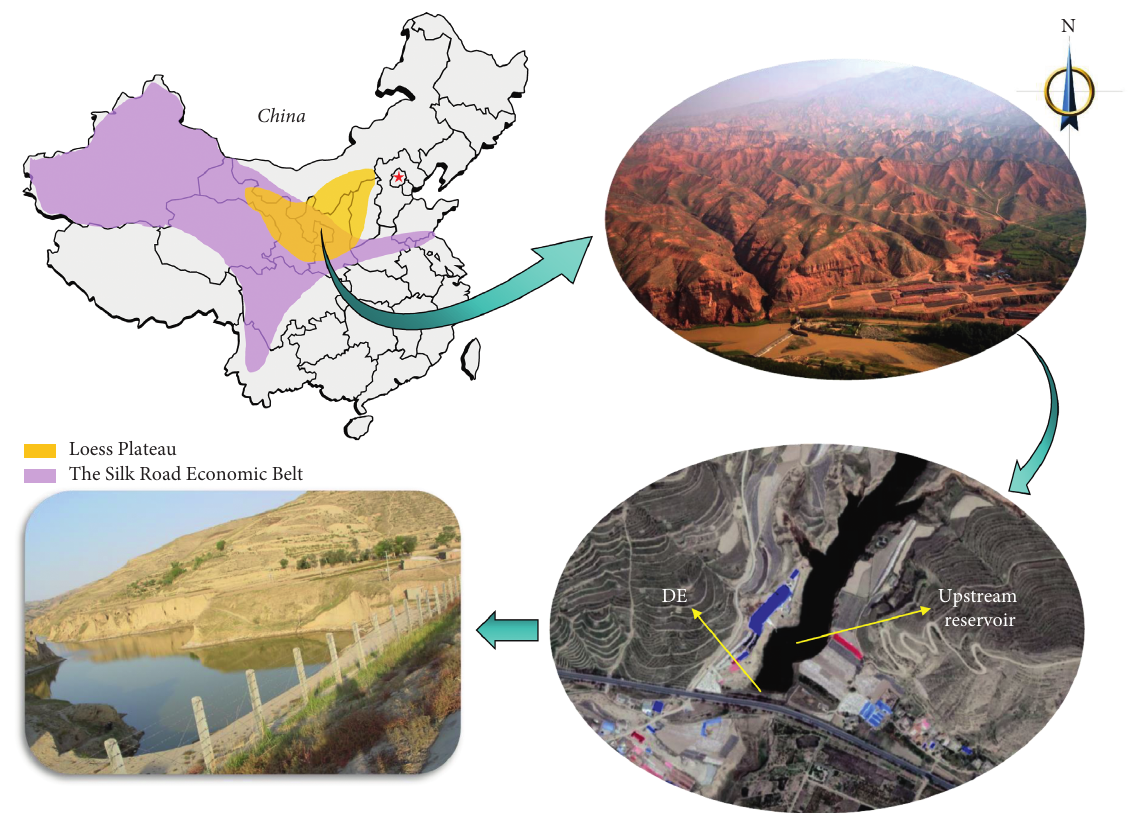
Figure 1: Study area and a typical DE.